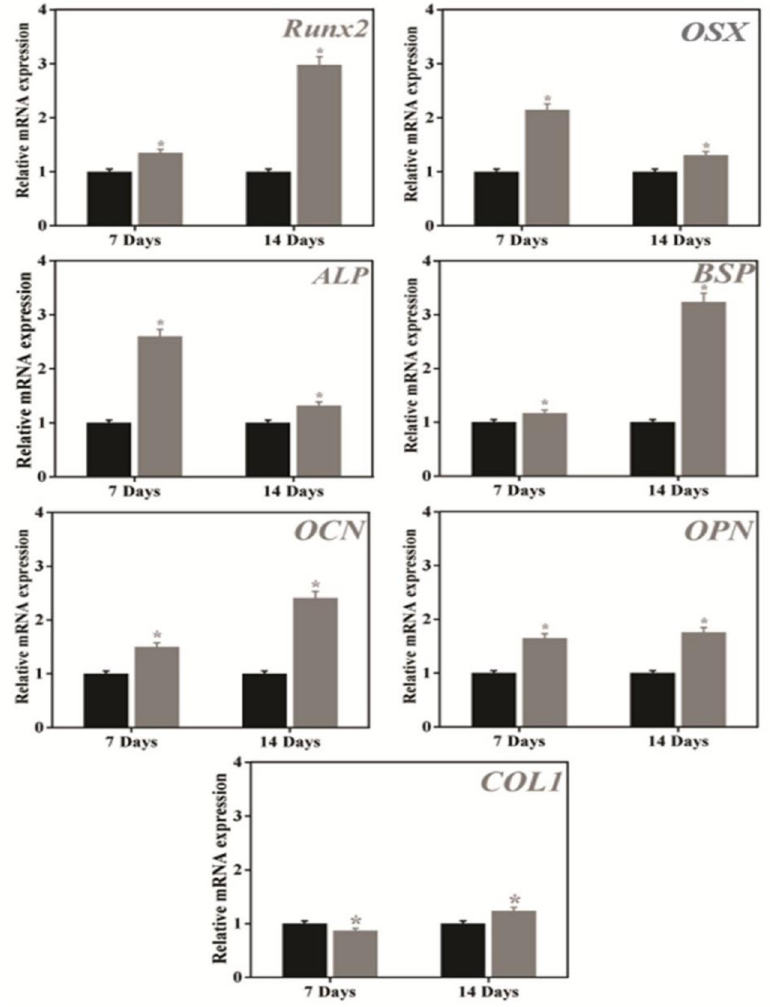
Fig 8. Real-time polymerase chain reaction (qRT-PCR) analysis of 2% CPI-treated hBMSCs after 7 days and 14 days of incubation. (a) Runx2 , (b) OSX , (c) ALP , (d) BSP , (e) OCN , (f) OPN , (g) COL1 . Data are mean ± SD of triplicated experiments, statistical significance at � p <